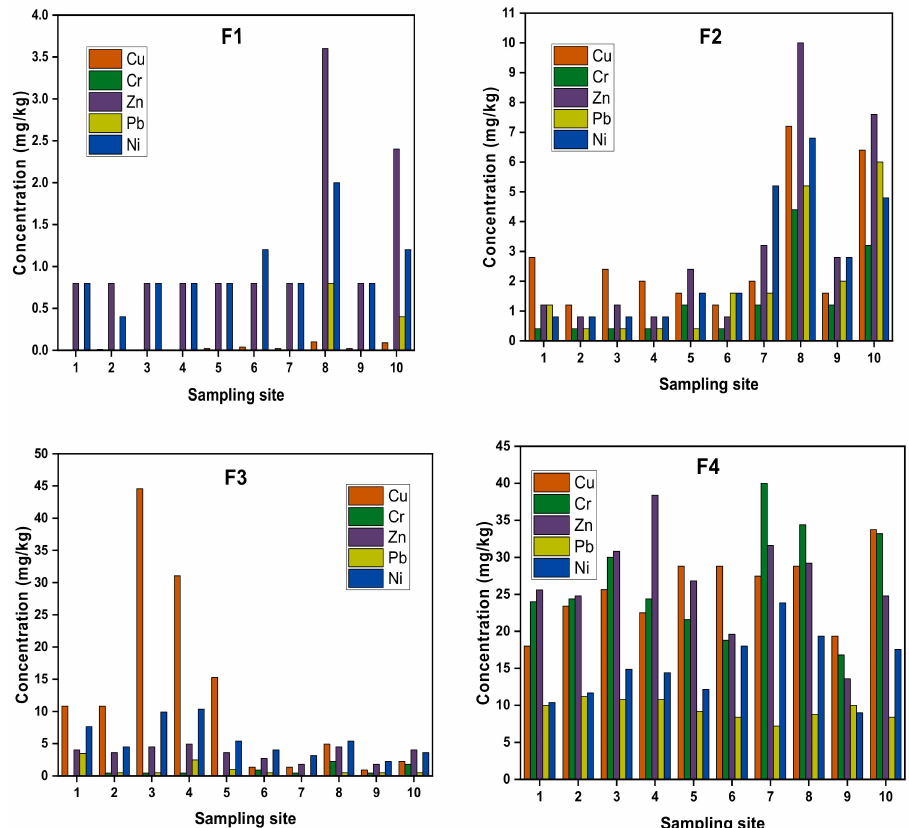
Figure 5. Plot of sampling site(s) vs concentration (mg /